Question: How would you classify this visualization?
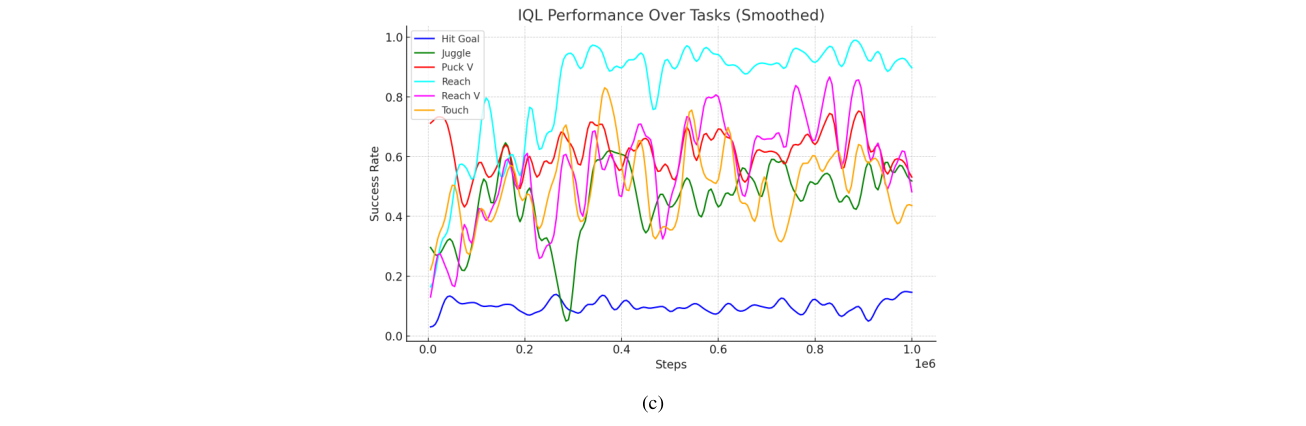
Answer: line